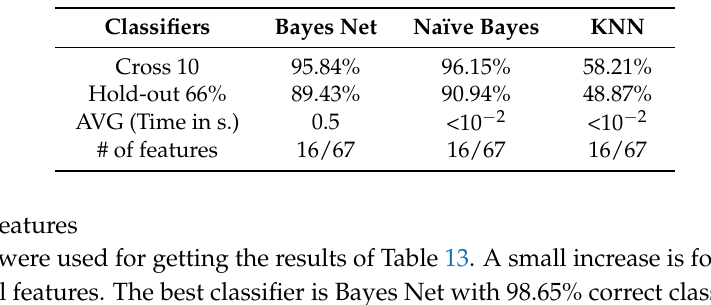
Table 12. Results using temporal features for IAM Online Handwriting Database.